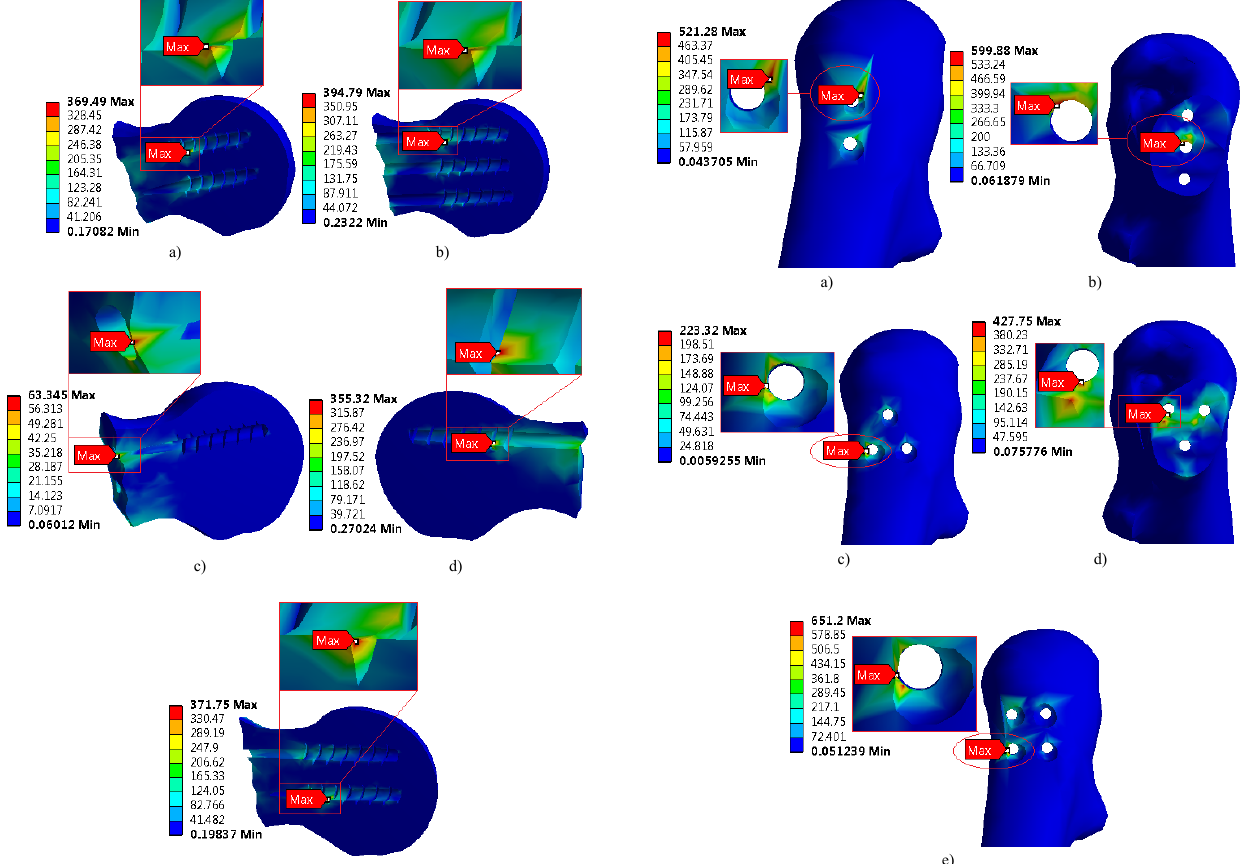
Figure 10. Stress distribution occurring at the lower proximity of femoral bone under axial loading: (a) dual parallel, (b) triple paral- lel, (c) triangle, (d) inverted triangle, and (e)